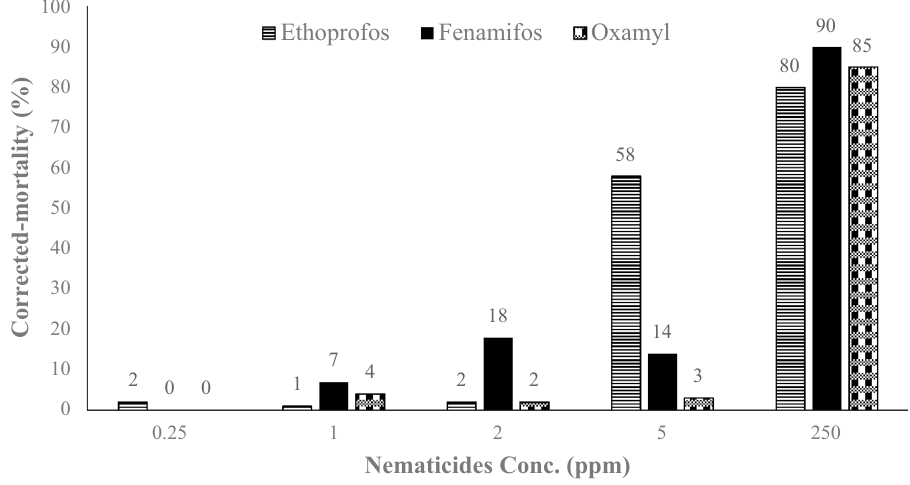
Figure 2. In vitro corrected- mortality of Meloidogyne incognita juveniles treated with different concentrations of the three chemical nematicides at 72 h